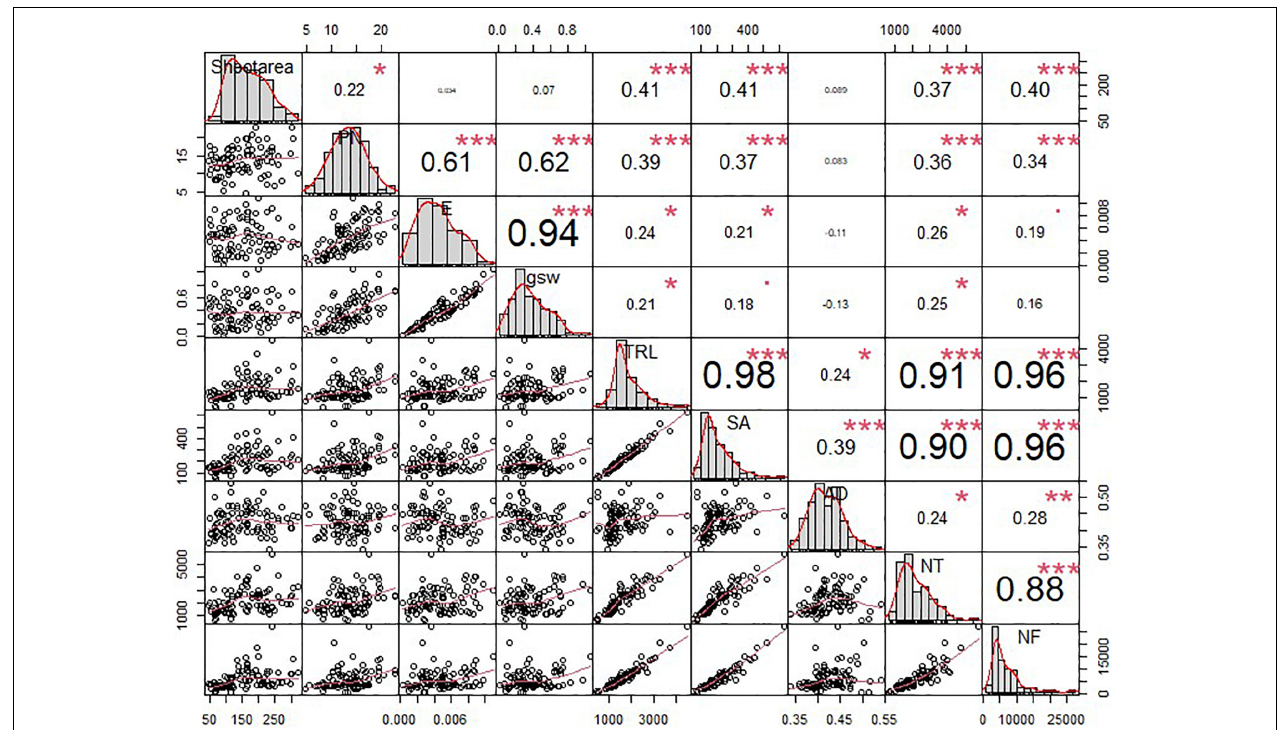
FIGURE 6 | Correlation analysis among the shoot and root traits of soybean cultivars. Error bars indicate standard error, and the asterisks indicate significant difference using the correlation test (*0.01 < P < 0.05; **0.001 < P < 0.01; *** P < 0.0001).